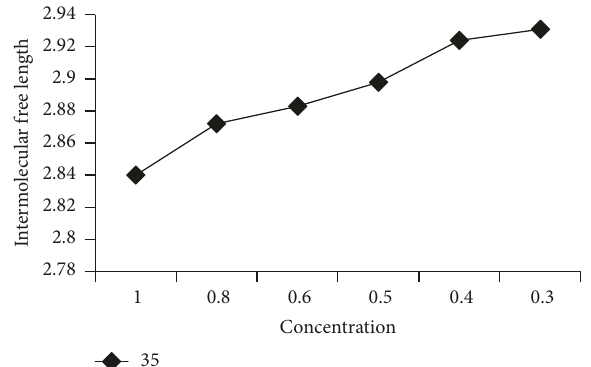
Figure 8: Variation of ultrasonic absorption with concentration at 35 ∘ C